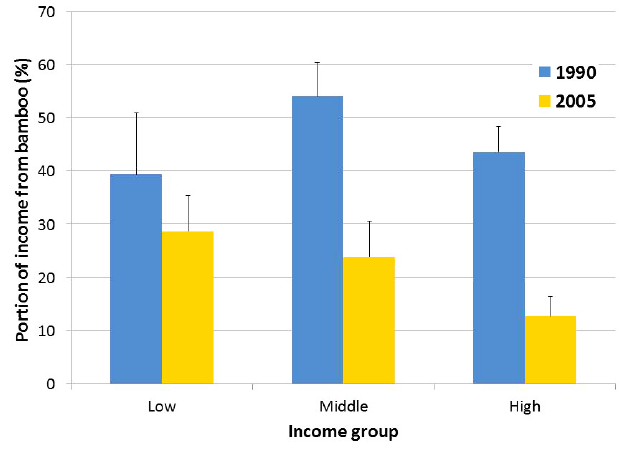
Fig. 6 . Relative contribution of bamboo to household income for the three income tertile groups: 1990 vs. 2005 (unpublished statistics for 1990 obtained from the Daxi village's handwritten notebooks; statistics for 2005 from Gutierrez et al